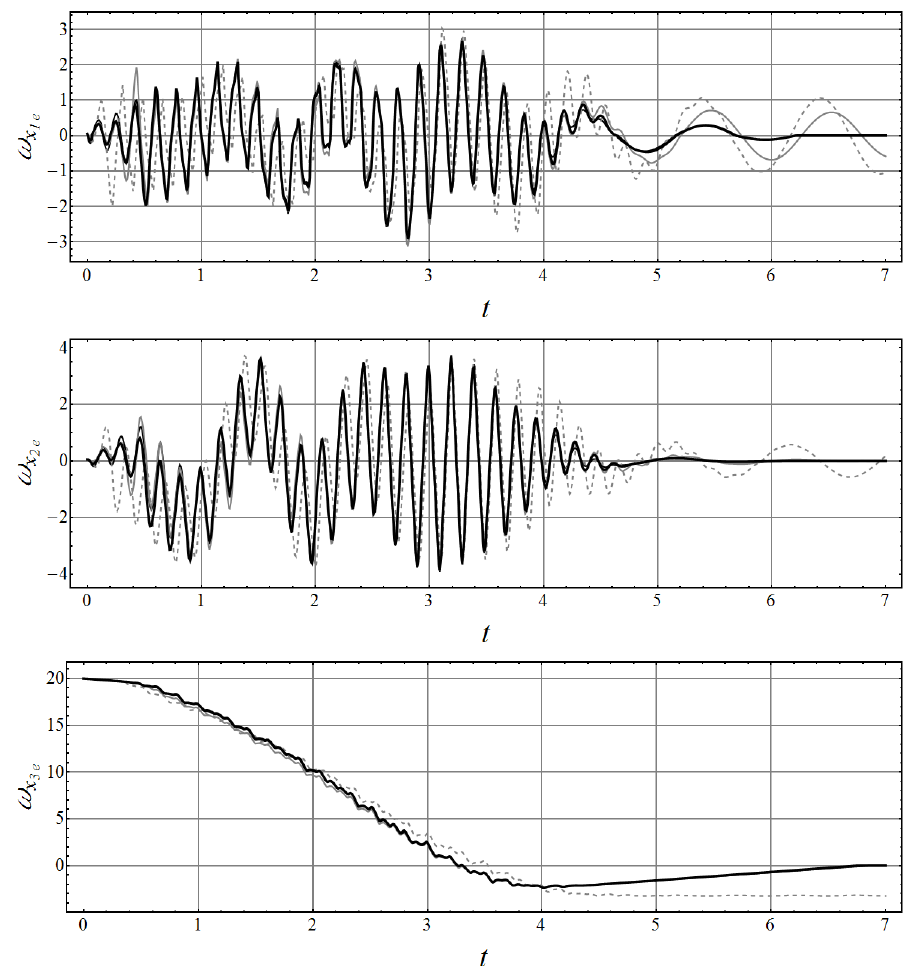
Fig. 3. The final fitting of the solutions to the models: 1 W  (black thick line), O  (grey continuous line), 1 P  (grey dashed line) and 3 P   (black thin